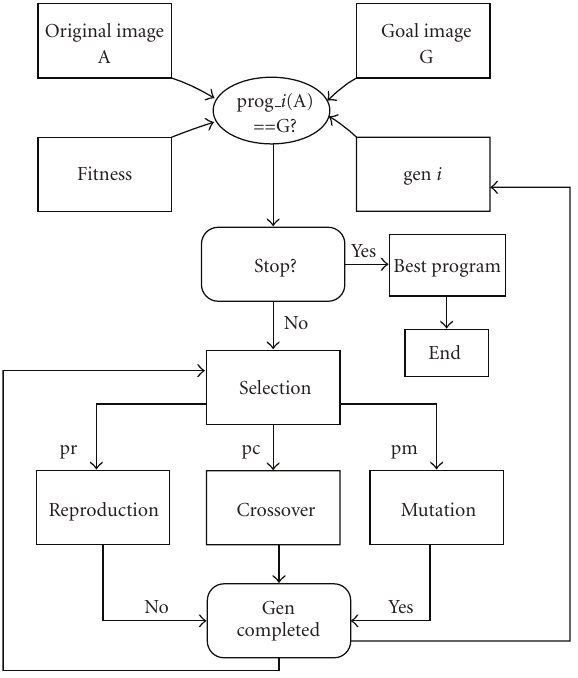
Figure 1: Flowchart of developed system. The index i refers to an individual in the population. The reproduction rate is pr, the crossover rate is pc, and the mutation rate is pm. The goal image can be created using an editor program or a processing program.